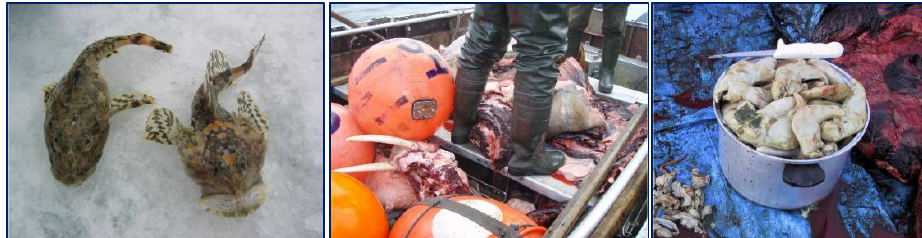
Figure 7. Examples of diverse non-commercial marine resources essential to the nutritional, cultural, and economic well-being of coastal communities in the northern Bering Sea/Bering Strait region. From left to right: sculpin, walrus, and clams from the walrus’ stomach.